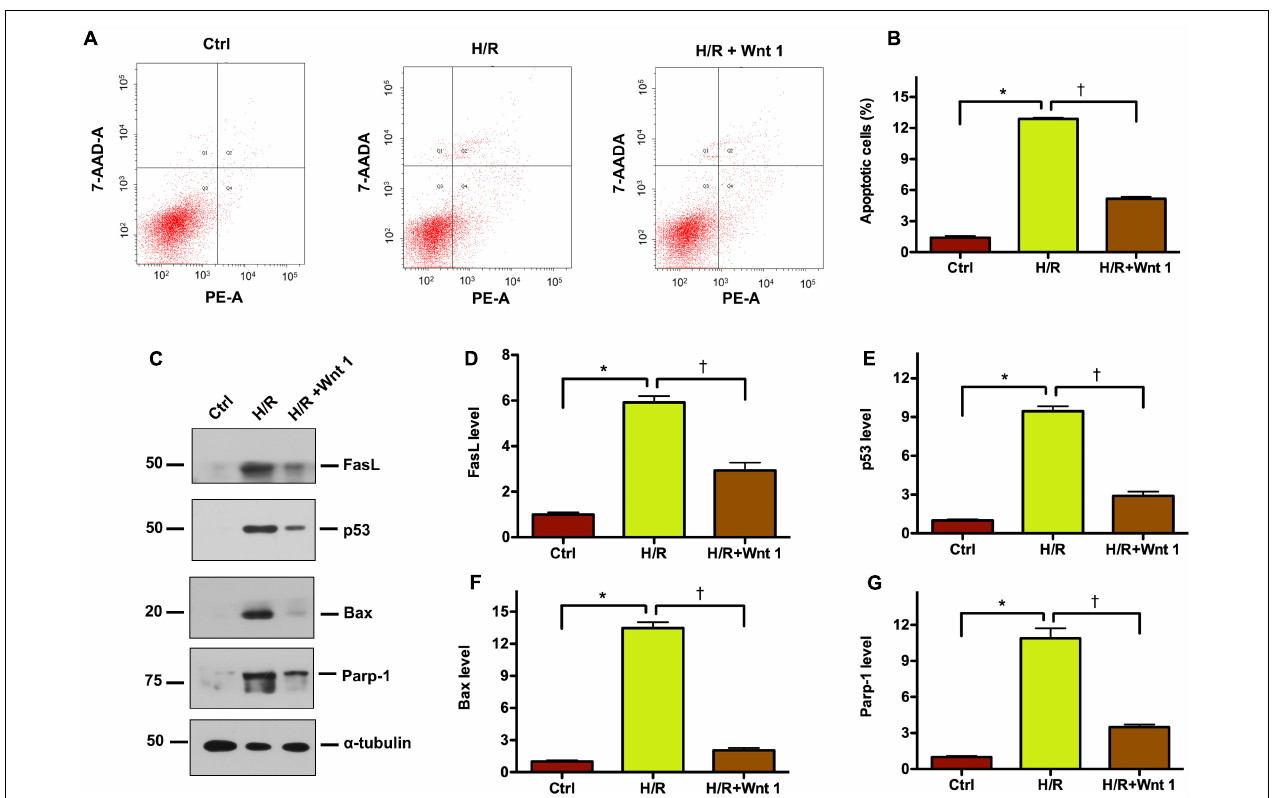
FIGURE 8 | Exogenous Wnt1 protects tubular cells against apoptosis induced by hypoxia-reoxygenation (H/R) injury in vitro. (A) Representative FACS analyses show that Wnt1 inhibited hypoxia/reoxygenation (H/R)-induced cell apoptosis. HKC-8 cells were pre-expressed with exogenous Wnt1, followed by incubation in hypoxic condition for 48 h and then reoxygenation for 2 h. (B) Graphic presentation shows the percentage of apoptotic cells in different groups as indicated. The PE-labeled Annexin V-positive cells were counted by flow cytometry. * P < 0.05 versus controls; † P < 0.05 versus H/R ( n = 3). (C) Representative Western blot analyses show protein expression of FasL, p53, Bax, and Parp-1 in HKC-8 cells. (D–G) Graphic presentations show the relative abundances of FasL, p53, Bax, and Parp-1 in HKC-8 cells. * P < 0.05 versus controls; † P < 0.05 versus H/R ( n =